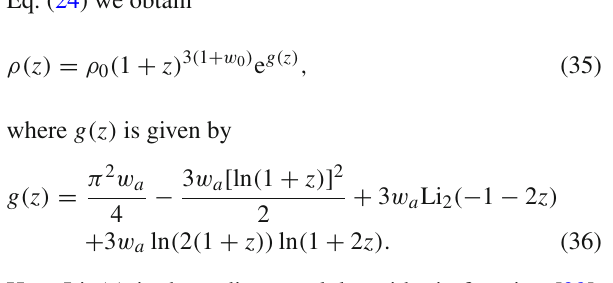
pletely stable function X ( z ) . Notice that the stability region implies a single-valued F ( X ) function, as is also the case in Model B and A.